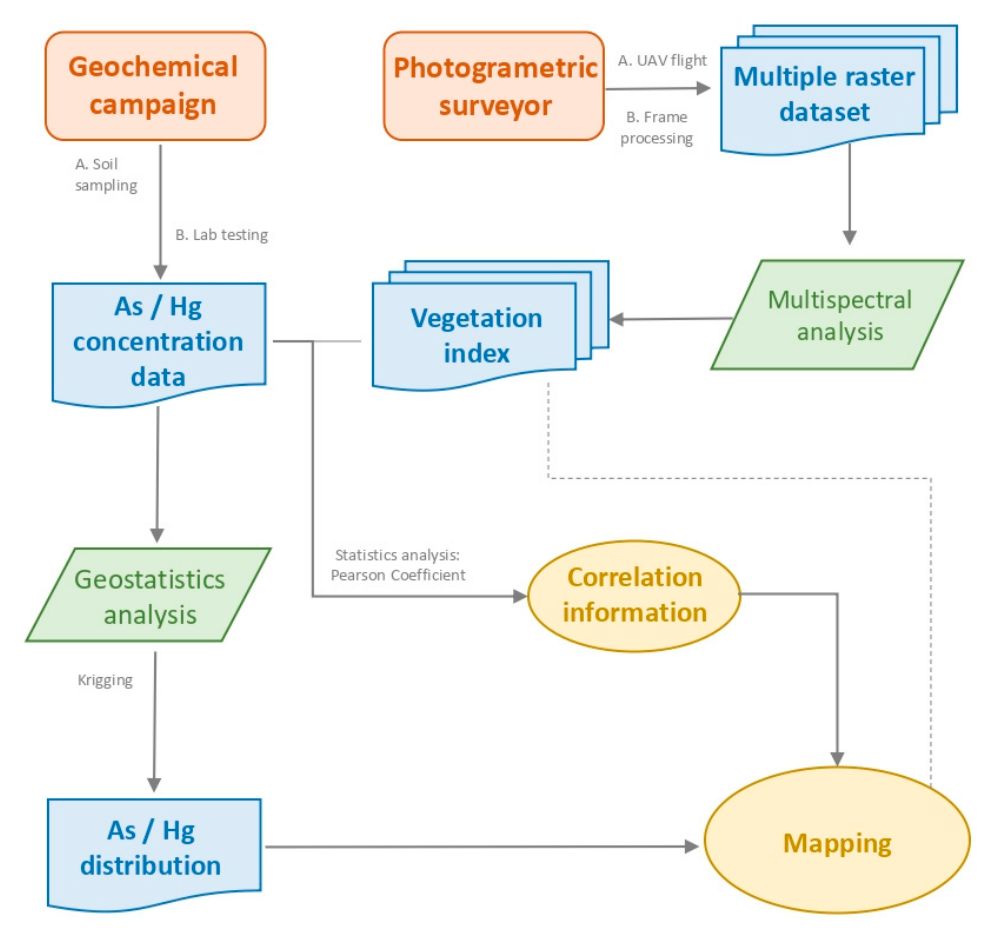
Figure 1. Research workflow .